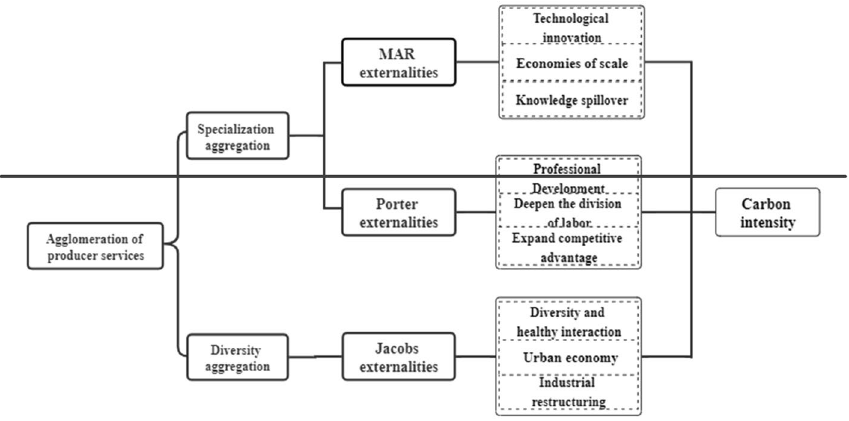
Figure 1. Mechanism of the effect of producer services